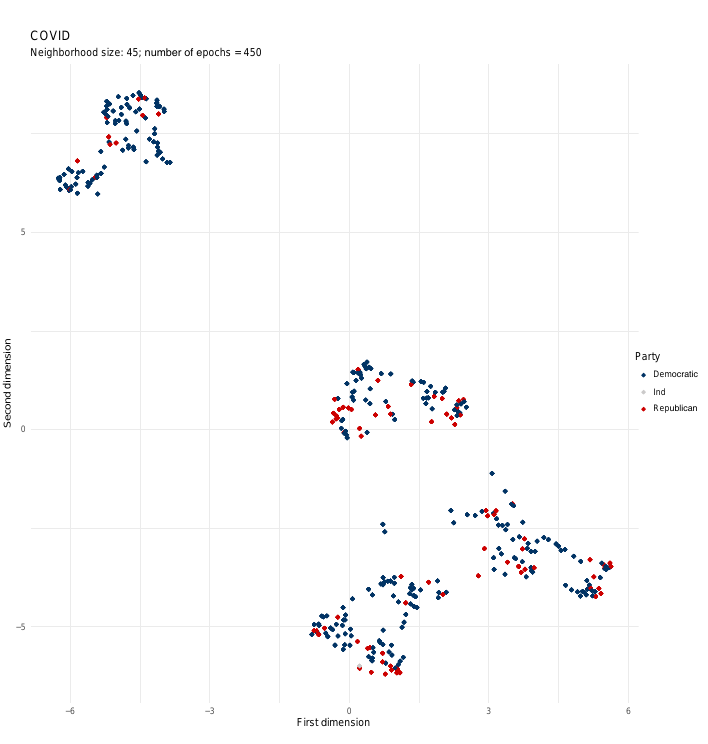
Fig. 2 COVID policymaking